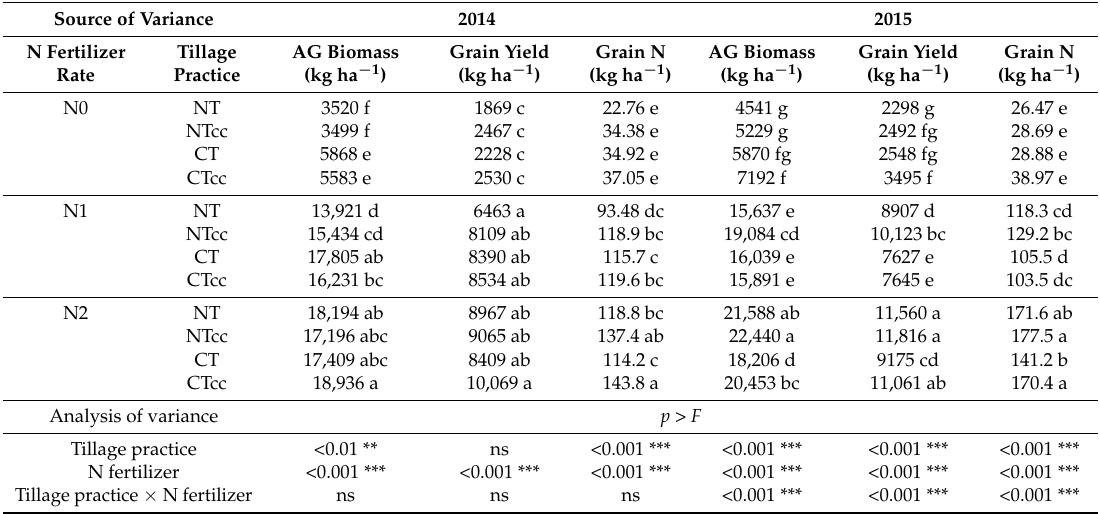
Table 1. Impact of tillage, cover crops and N fertilization on agronomic